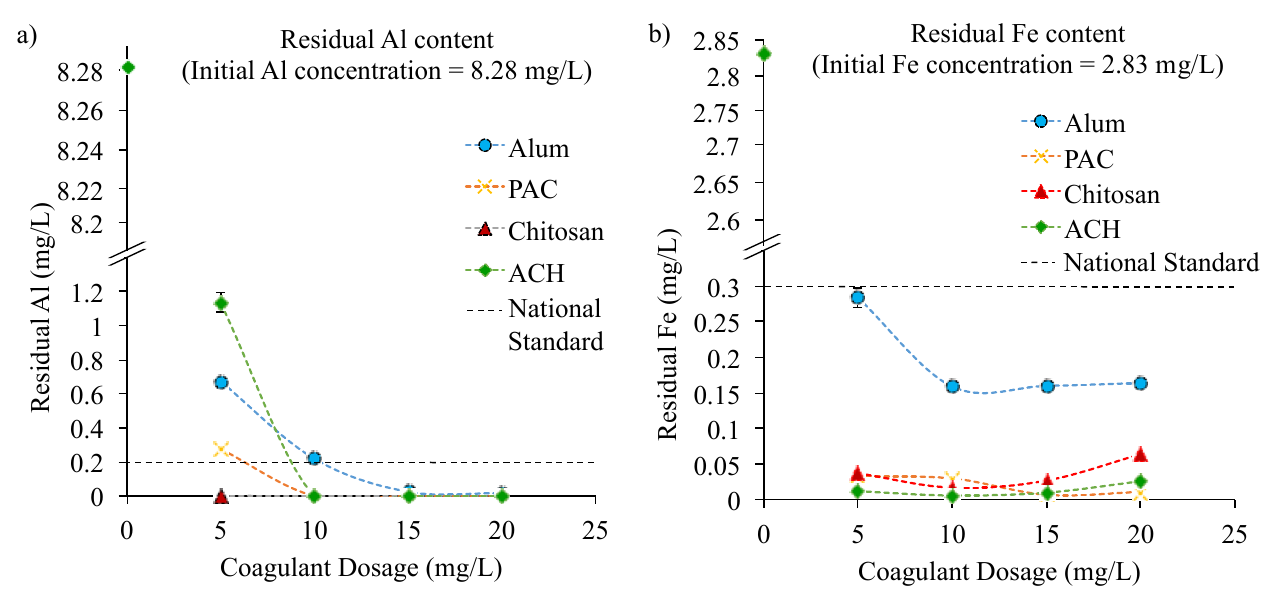
Figure 4. Concentration of ( a ) Al and ( b ) Fe in the treated water (initial water turbidity: 130.30/NTU, pH: 6.80; initial metal concentration: Al, 8.28 mg/L; Mn, 0.09 mg/L; Fe, 2.83 mg/L; national standard of drinking water content; Al = 0.20 mg/L, Mn = 0.10 mg/L and Fe = 0.30 mg/L).